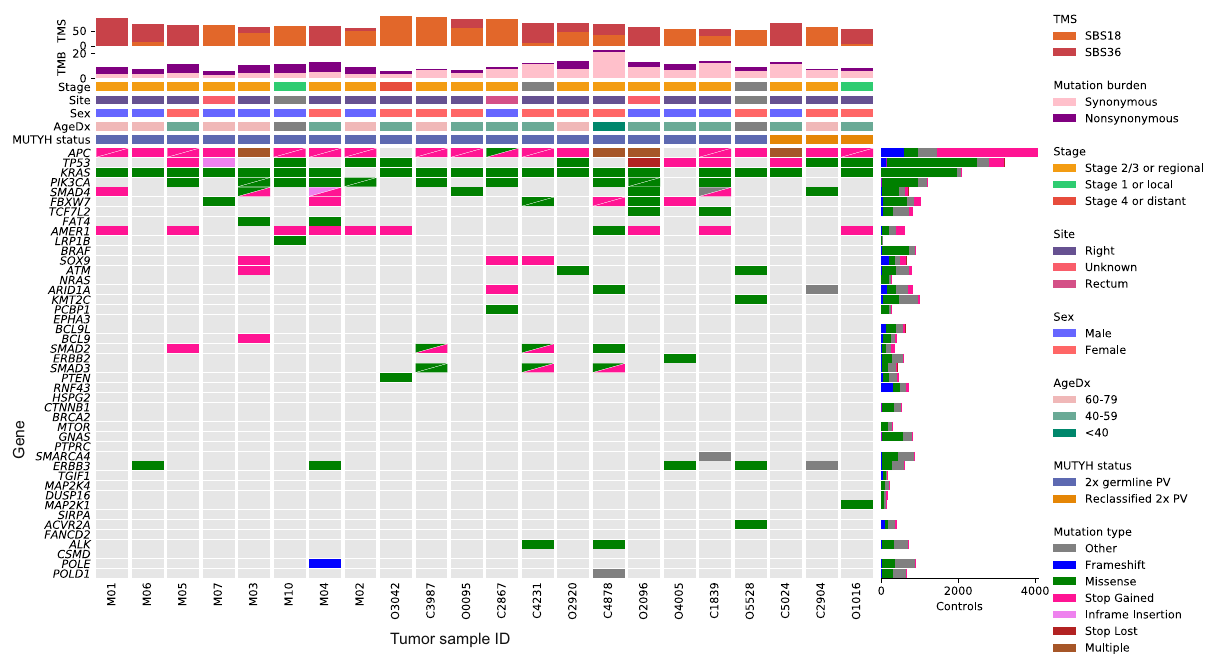
Fig. 5 Somatic mutation landscape of the 19 CRCs from biallelic MUTYH pathogenic variant carriers, as well as the 3 CRCs from carriers of variants of uncertain clinical signi fi cance that were reclassi fi ed as likely pathogenic in this study. The 40 most commonly mutated CRC genes 48 are included, as well as known CRC genes ALK , CSMD1 , POLE , and POLD1 . KRAS was found to be signi fi cantly more commonly mutated in our biallelic MUTYH carrier CRCs.